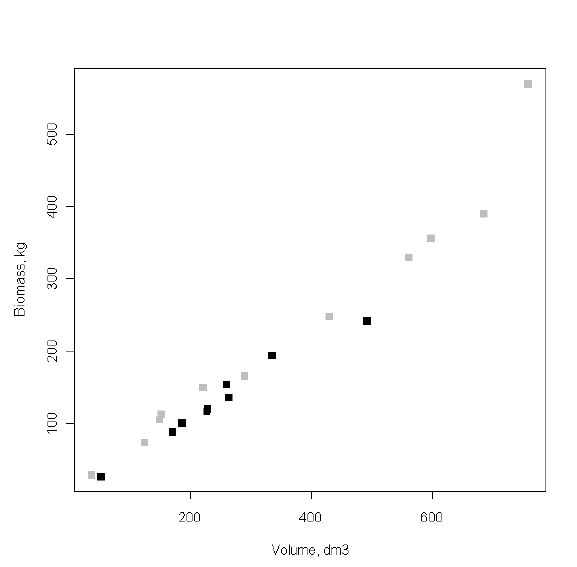
Figure 3: Tree volume (dm 3 ) vs. total biomass (kg) for pines (grey) and spruces (black).